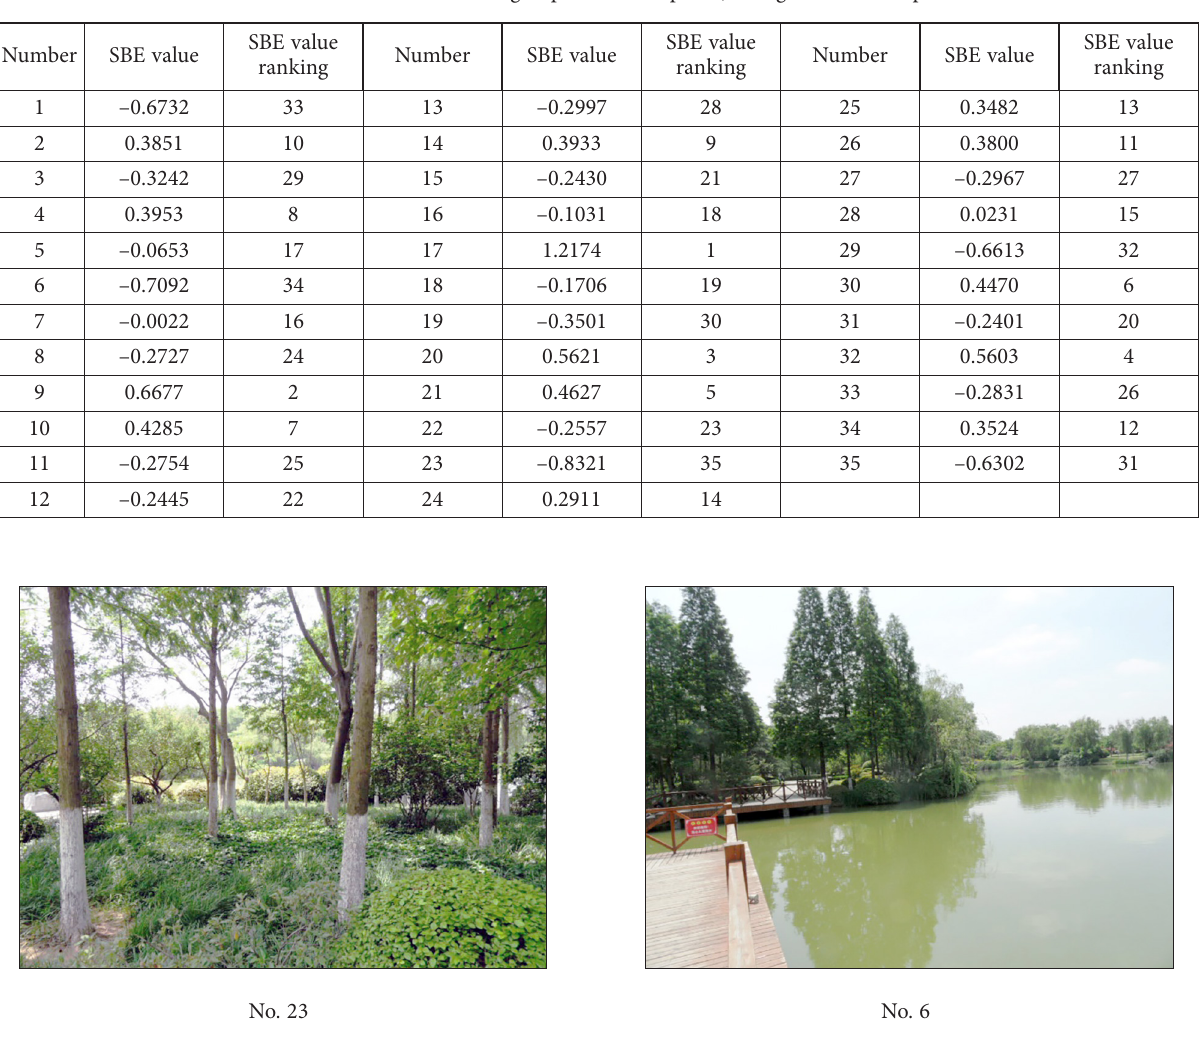
Figure 2. Photos with lower SBE value of plant